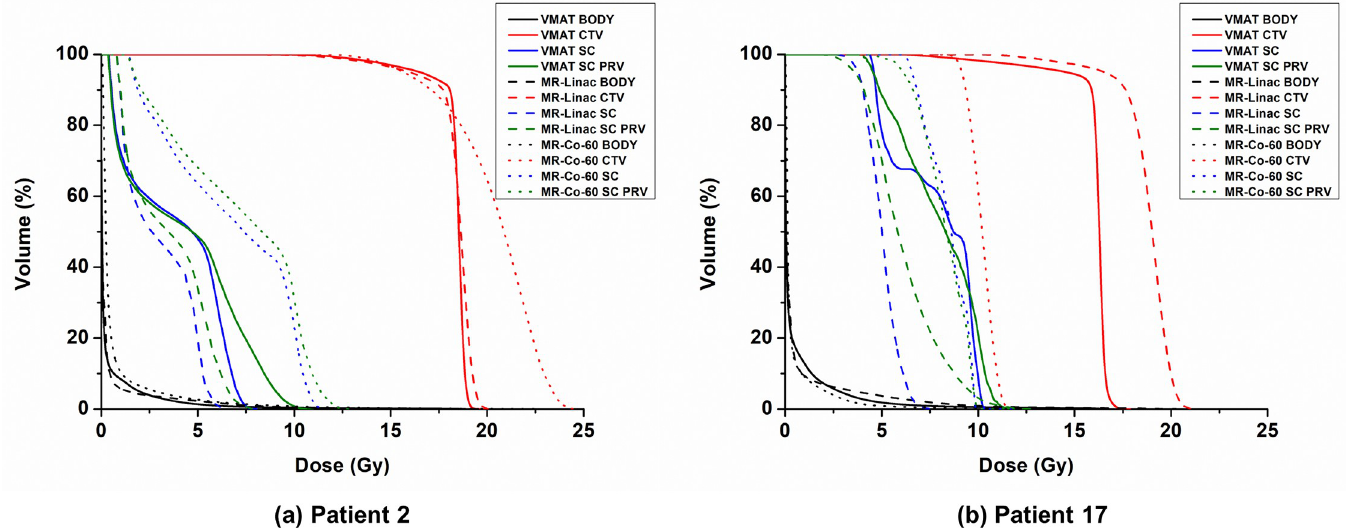
Fig 2. Dose volume histograms (DVHs) of the volumetric modulated arc therapy (VMAT) plans, intensity modulated radiation therapy (IMRT) plans with the MRIdian Linac system (MR-linac), and IMRT plans with the ViewRay system (MR-Co-60) of two representative cases for spine stereotactic ablative radiotherapy (SABR). One (patient No. 2) is a representative case with a prescription dose of 18 Gy for VMAT, MR-linac IMRT, and MR-Co-60 IMRT plans (a). The other (patient No. 17) is a representative case with prescription doses of 16 Gy, 18 Gy and 9.5 Gy for VMAT, MR-linac IMRT, and MR-Co-60 IMRT plans, respectively (b). The DVHs of VMAT, MR-linac IMRT, and MR-Co-60 IMRT plans are plotted as solid, dashed and dotted lines, respectively (black color: whole body, red color: clinical target volume, blue color: spinal cord, and green color: spinal cord planning organ-at-risk volume).